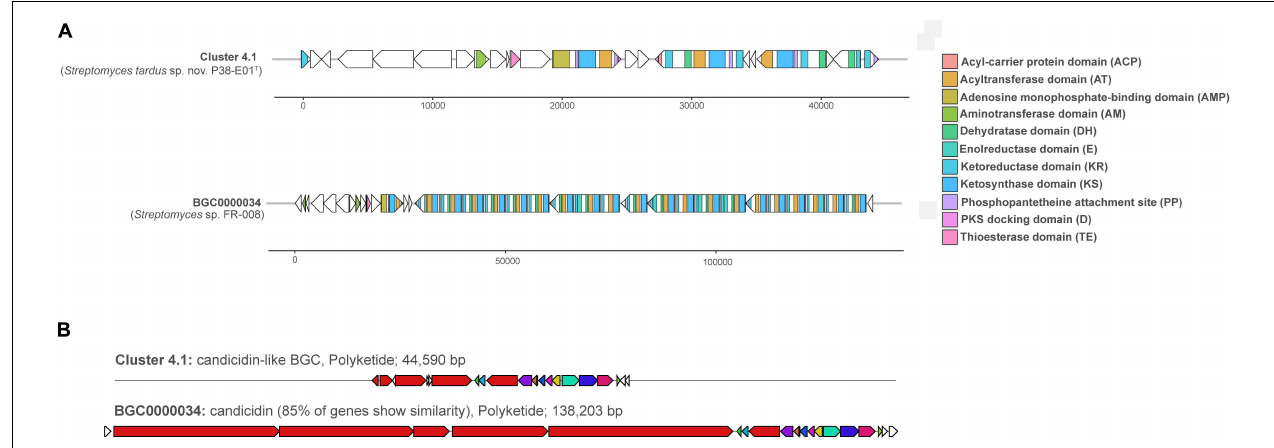
FIGURE 5 | Annotation and similarity of a candicidin-like biosynthetic gene cluster (BGC) (BGC 9.1) and its analogous cluster (BGC0000034) predicted by antiSMASH (Blin et al., 2017) from strain P38-E01 T . (A) Annotation of both clusters with ORFs are depicted as white arrows, and BGC domains are color coded. (B) Similarity of BGC 9.1 from strain P38-E01 T to a PKS candicidin cluster (BGC0000034) from Streptomyces sp. FR-008 (Chen et al., 2003).